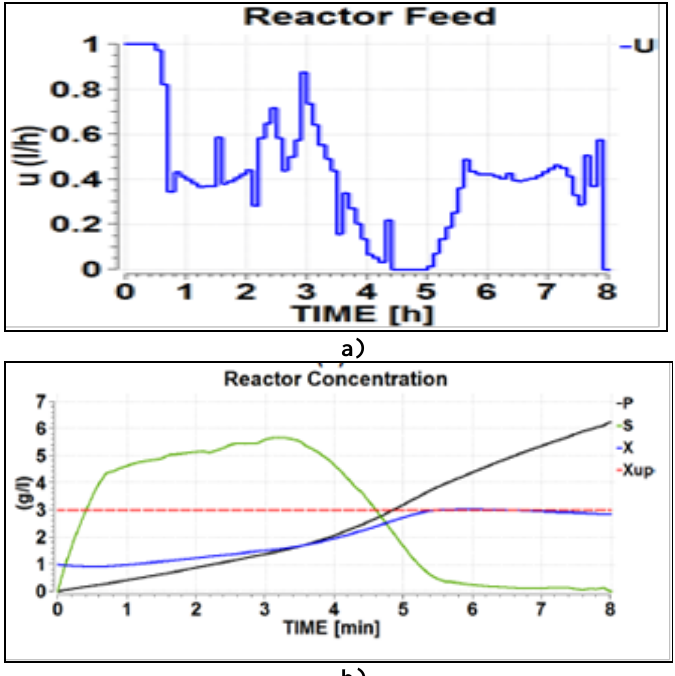
Figure 17: (a) Manipulated and (b) constrained variables.